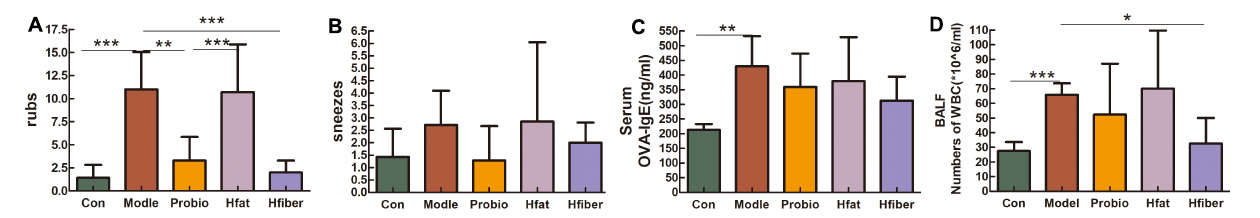
FIGURE 2 | Allergy symptoms resulting from different diets influencing the effect of L. paracasei . (A) Number of nose rubs. (B) Number of sneezes. (C) Altered serum level of OVA-specific IgE. (D) Absolute number of WBCs in BALF 24 h after final challenge with OVA. Each bar represents the mean ± SEM; * p < 0.05, ** p < 0.01, and *** p <